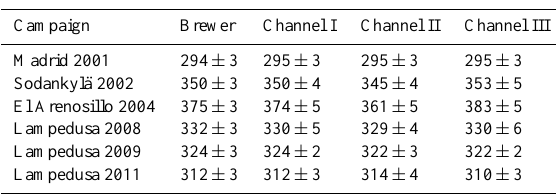
Table 3. Average ozone values measured by the Brewer and the three Microtops II channels for the six campaigns. Only data for airmasses small than 3 were used. The daily standard deviation is